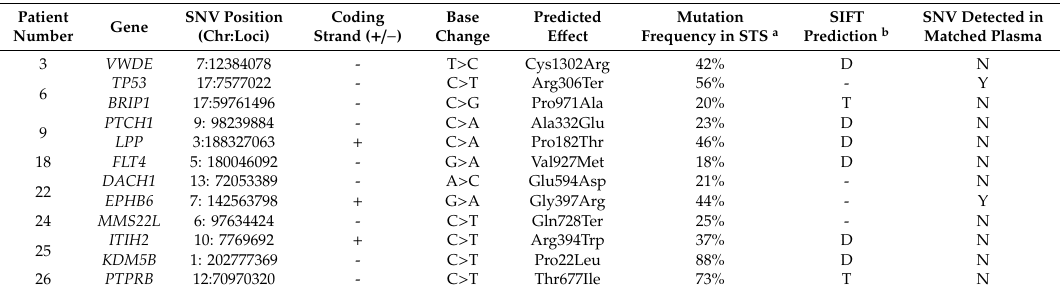
Table 3. SNVs targeted in STS patient plasma using ddPCR. a Mutation frequencies from WES analysis. b The Sorting Intolerant From Tolerant software package (SIFT) was used to predict the e ff ect of each SNV, D–damaging, T–tolerated, - no prediction o ff